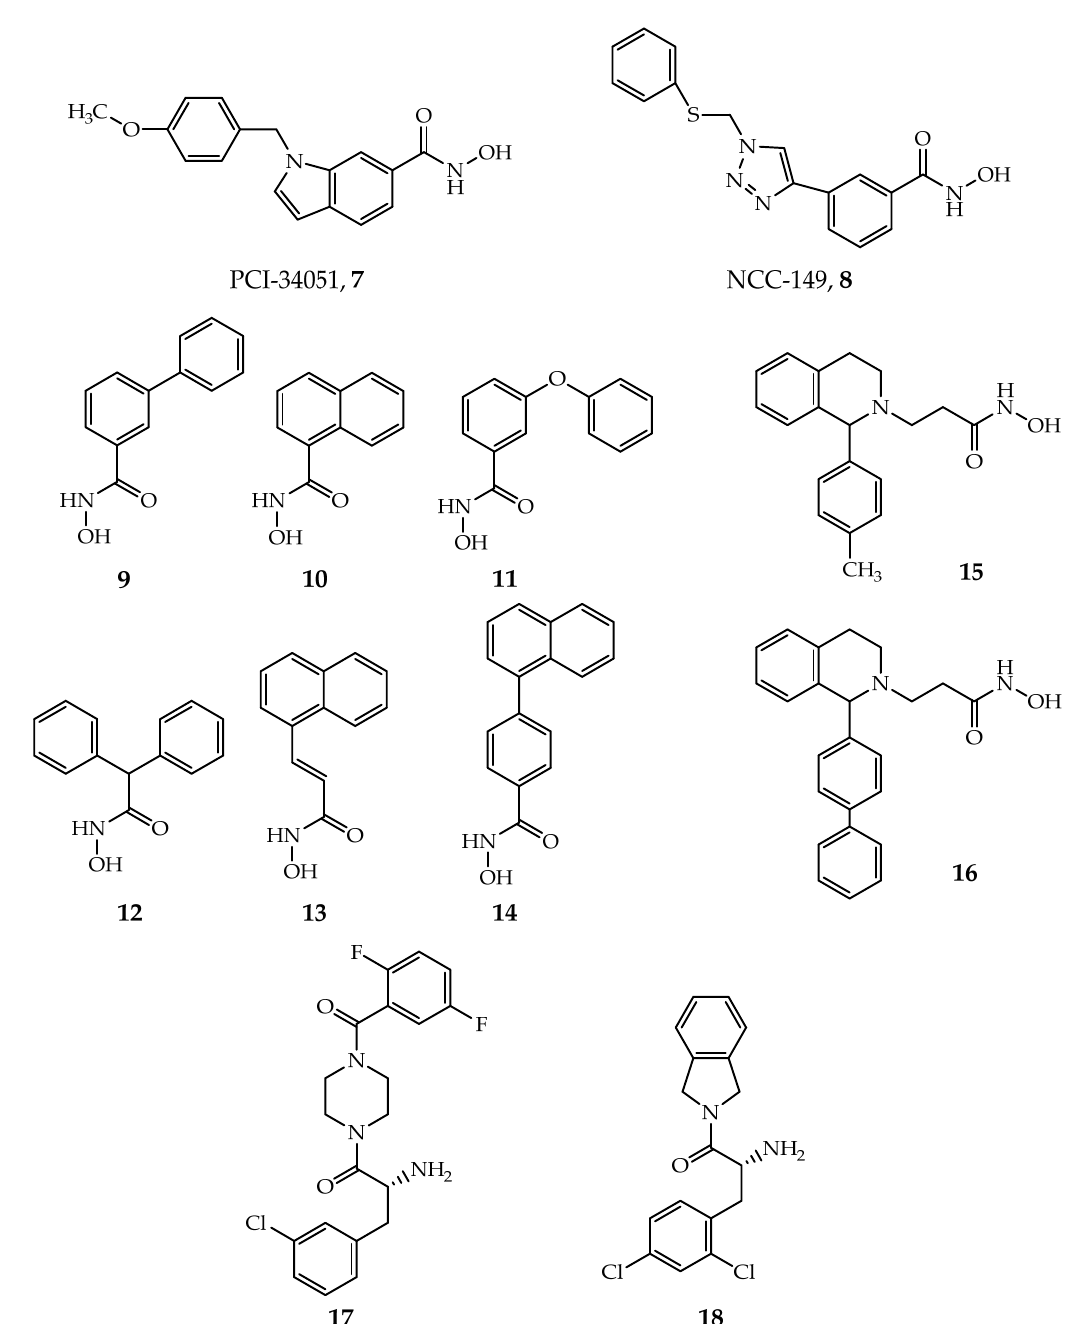
Figure 6. Selective inhibitors of HDAC8.